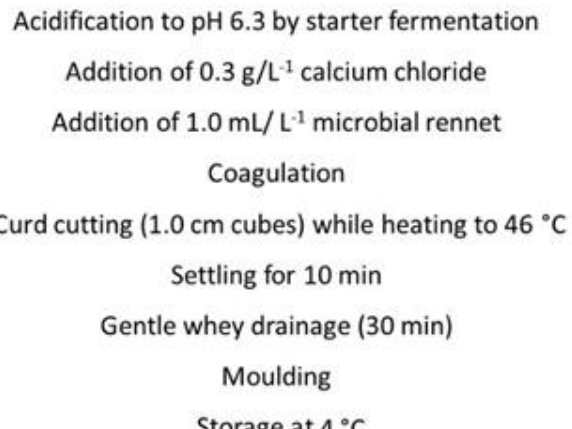
Figure 1. Technological scheme used for donkey milk cheesemaking.